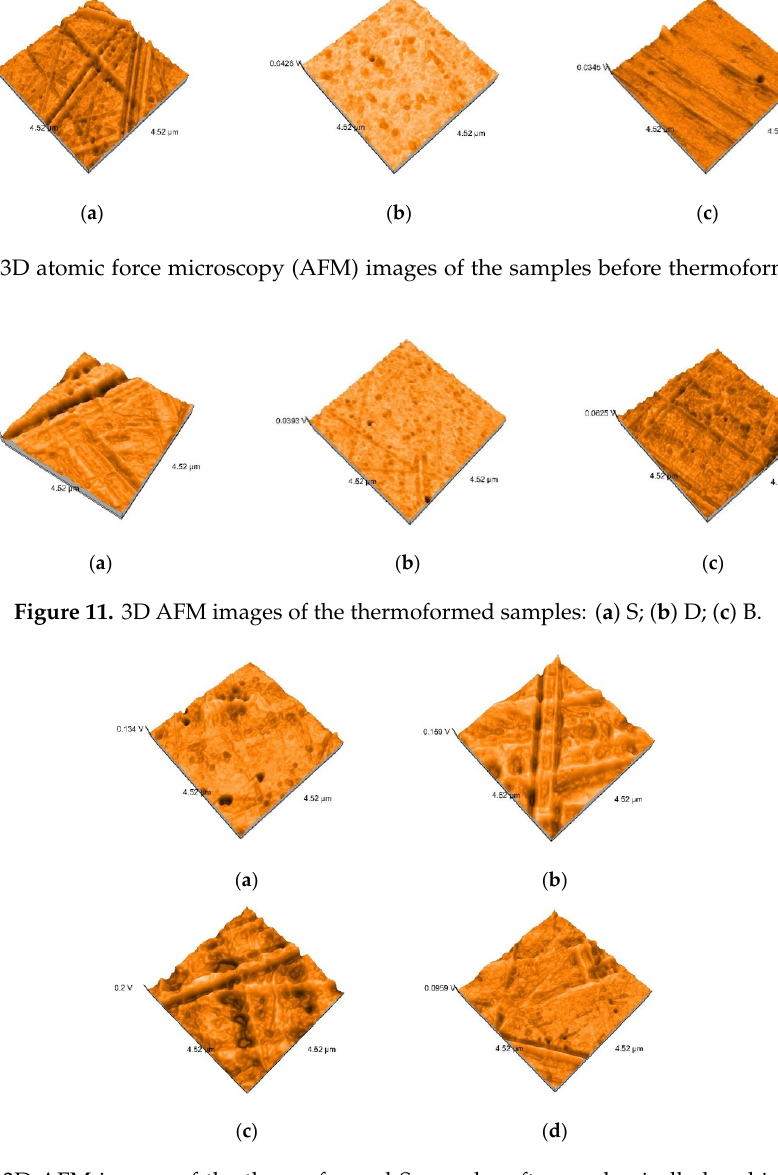
( c ) Figure 13. 3D AFM images of the thermoformed D samples immersed in K: ( a ) DKP (Sa = 7 nm, Sp = 26 nm, Sv = − 32 nm); ( b ) DKT (Sa = 6.7 nm, Sp = 58 nm, Sv = − 27 nm); ( c ) DKX (Sa = 8.6 nm, Sp = 43 nm, Sv = − 50 nm). ( a ) ( c ) Figure 14. 3D AFM images of the thermoformed B samples immersed in W: ( a ) DKP BWP (Sa = 23 nm, Sp = 52 nm, Sv = − 56 nm); ( b ) BWT (Sa = 48 nm, Sp = 110 nm, Sv = − 99 nm); ( c ) BWX (Sa = 15 nm, Sp = 63 nm, Sv = − 54 nm). Related to mean nanoroughness values Sa, D samples have demonstrated the most constant behavior, while B samples are visibly influenced by W (Figure 15a). This can be explained by the difference in the structure of the materials. Referring to mean values Sa, as well as to peak height values Sp, valley depth values Sv, D samples registered the lowest values, while the other two (S and B) intersect as values (Figure 15b).